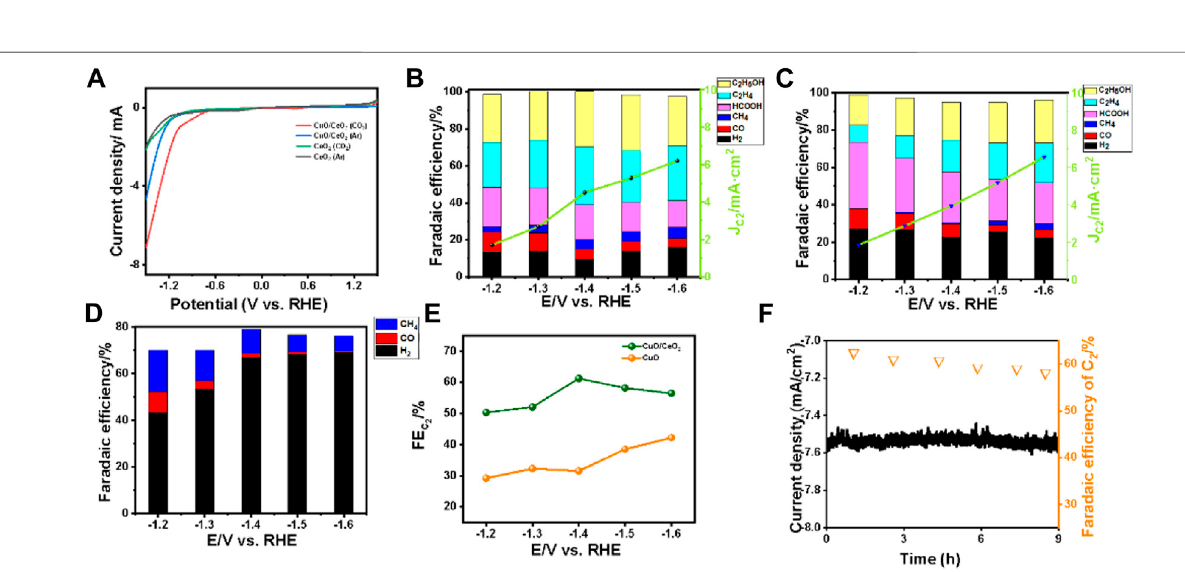
FIGURE 3 | (A) SEM images of CeO images of CuO/CeO 2 ; (G) HRTEM images of CuO/CeO 2 ; (H) SAED pattern of CuO/CeO 2 ; (I – L) EDS mapping of CuO/CeO 2 .